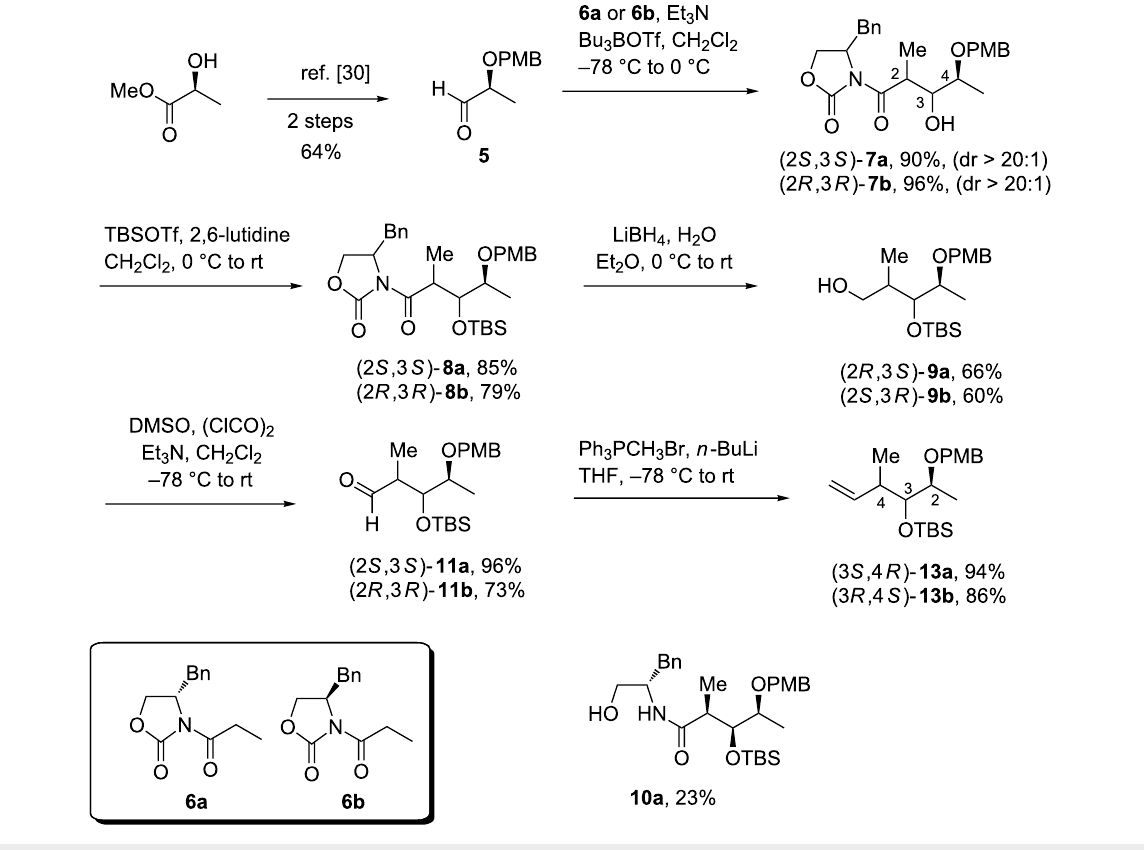
After protection of the free hydroxy group, the reduction of the N -acyl oxazolidinones 8 into primary alcohols 9 was accom- plished by LiBH 4 in presence of water or LiAlH 4 [32].